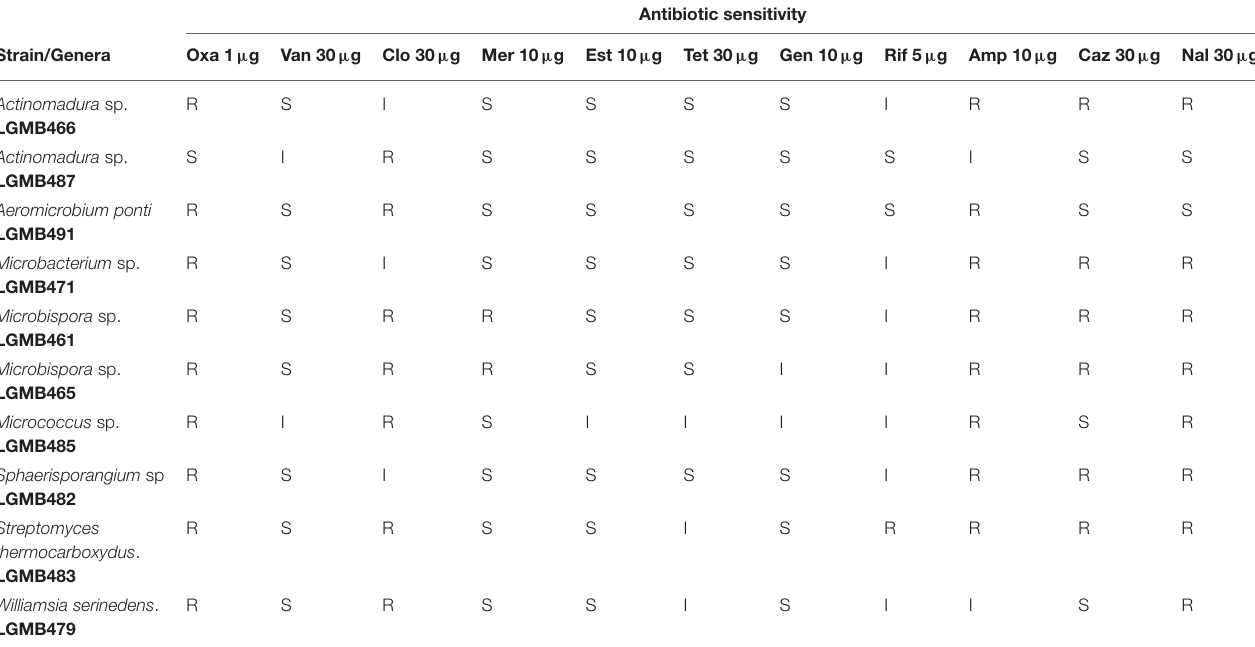
TABLE 2 | Antibiotic sensitivity pattern of endophytic